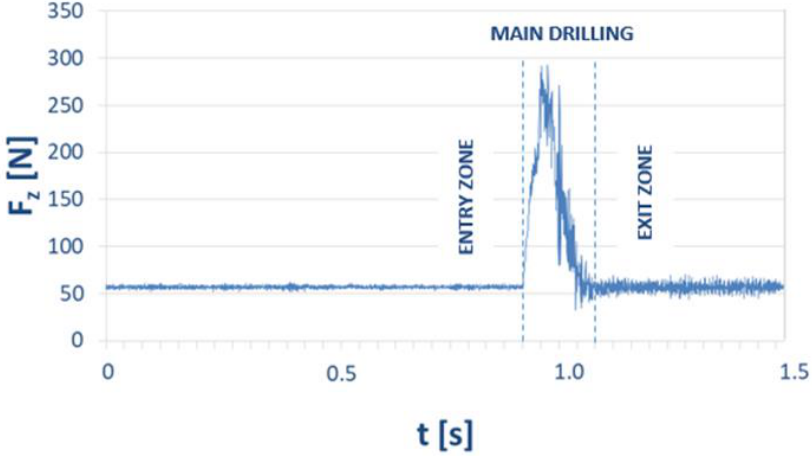
Figure 9. Example of time course of the cutting-force component F z for B2 material for the following technological parameters: cutting speed v c = 273 m/min, feed per tooth f z = 0.16 mm/tooth.